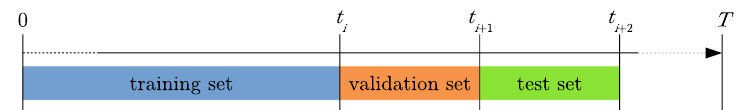
Figure 3. Prequential evaluation